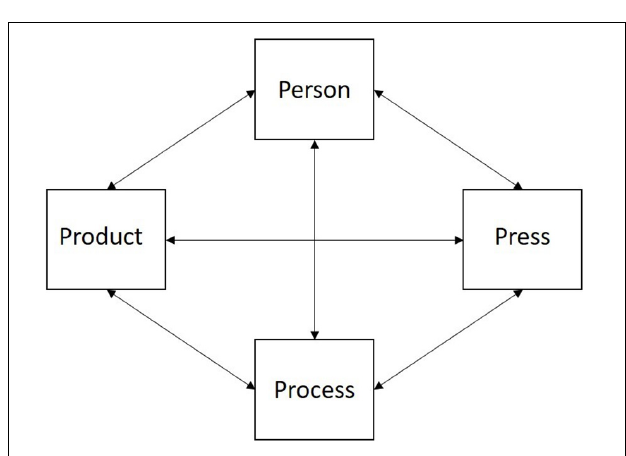
FIGURE 2 | The Four Ps as a “System.” Items are adapted from “ Creativity in engineering. Novel solutions to complex problems ” by Cropley (2015a,